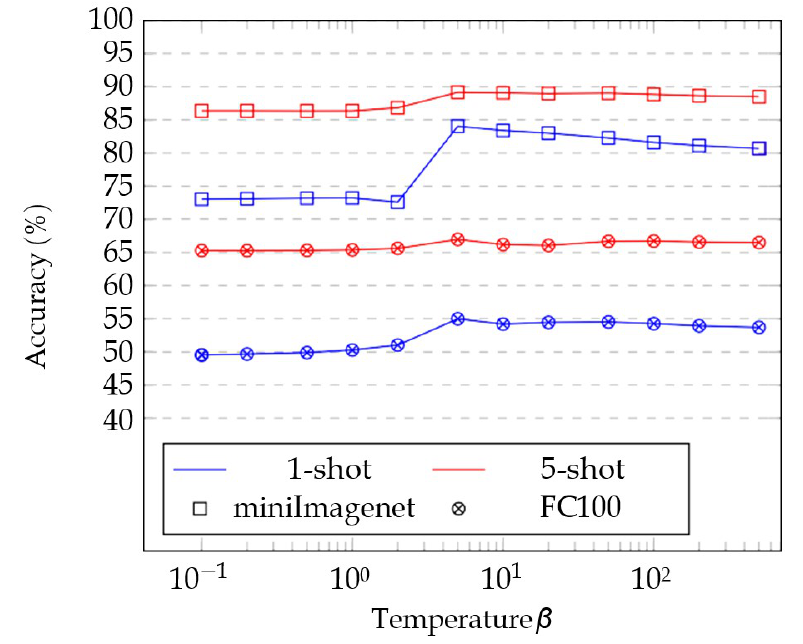
Figure A1. Ablation study of temperature of the soft K-means used in the transductive setting; we performed 10 5 runs for each value of β